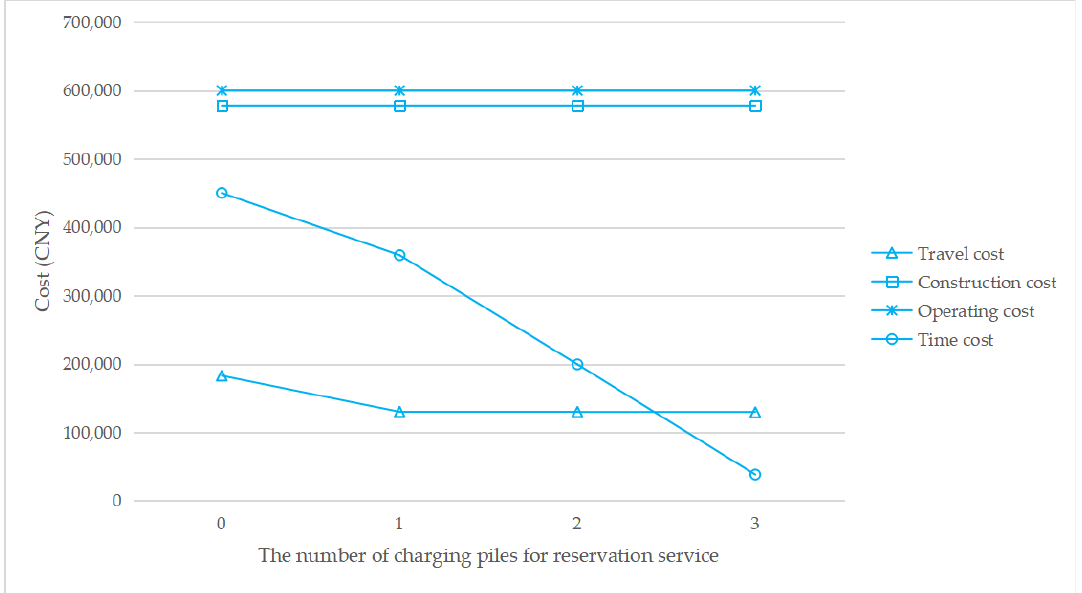
Figure 7. Cost change with a changing number of charging piles for the reservation service under τ = 0.05.